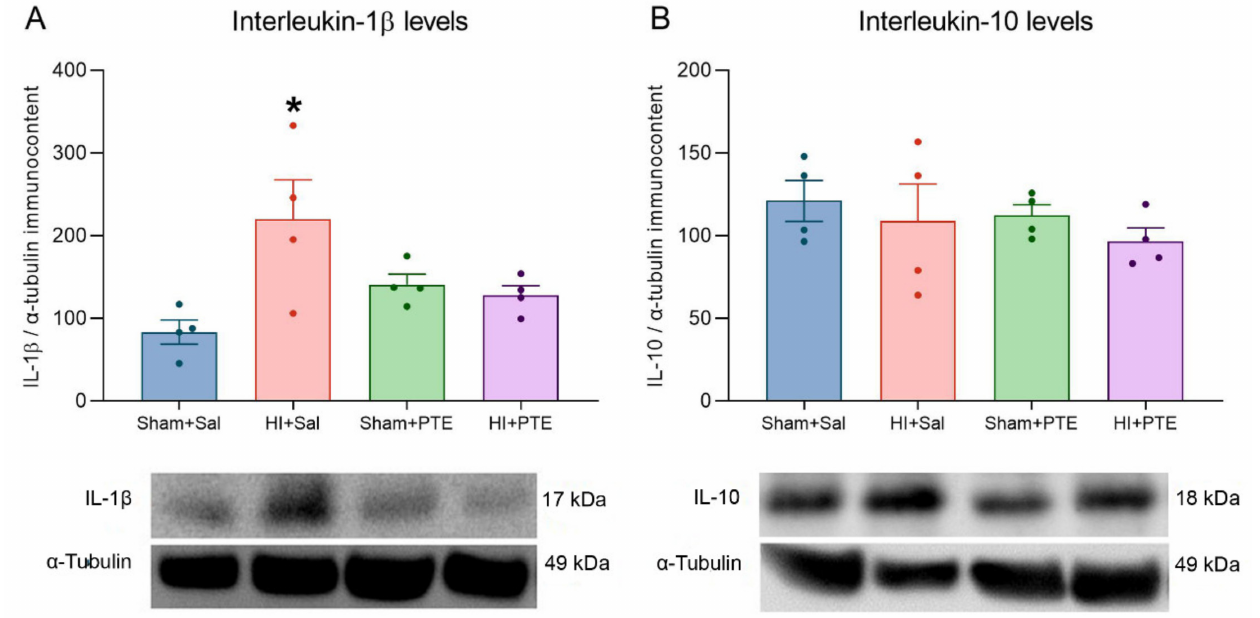
Figure 4. Interleukin immunocontent level assessment in the right hippocampus 72 h after neonatal HI and representative protein blots. Data are expressed as mean ± SEM. Interleukin-1 β (IL-1 β ) levels ( A ). Interleukins-10 (IL-10) ( B ). Results are plotted relative to the same sample used in all membranes (expression level considered as 100%) and normalized by α -Tubulin (mean ± SEM). * Injury effect (HI vs. control). n = 4 animals per group. Significance was accepted at p < 0.05 (*) (one-way